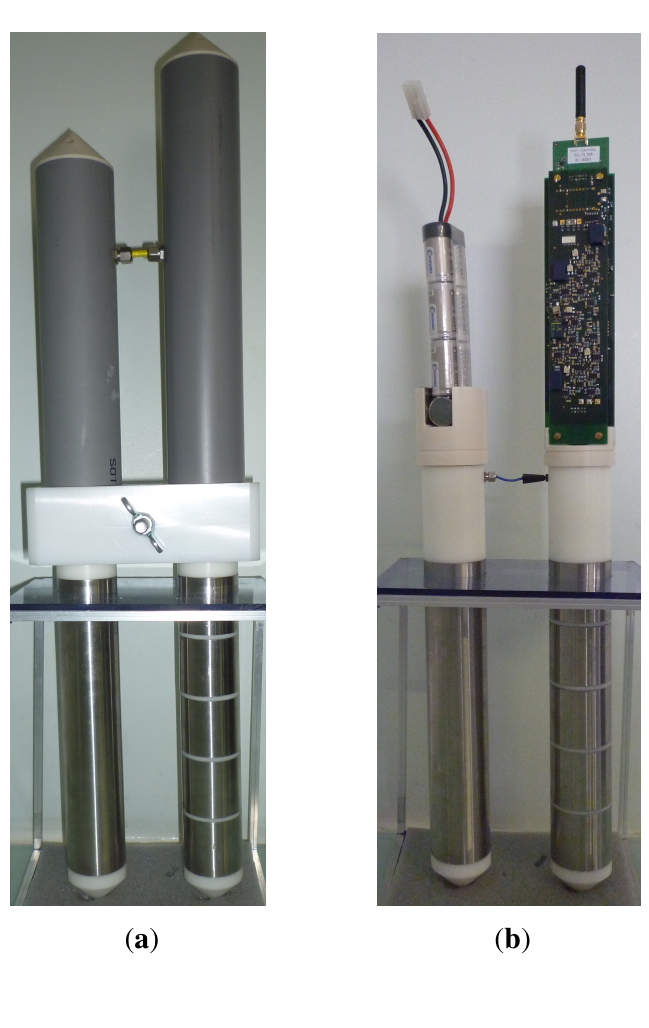
Figure 2. Photograph of the whole sensor with its electrodes and two aerial polyvinyl chloride tubes. Tubes house, respectively, the printed circuit boards and the battery for autonomous operations. ( a ) With the tubes; ( b ) Without the